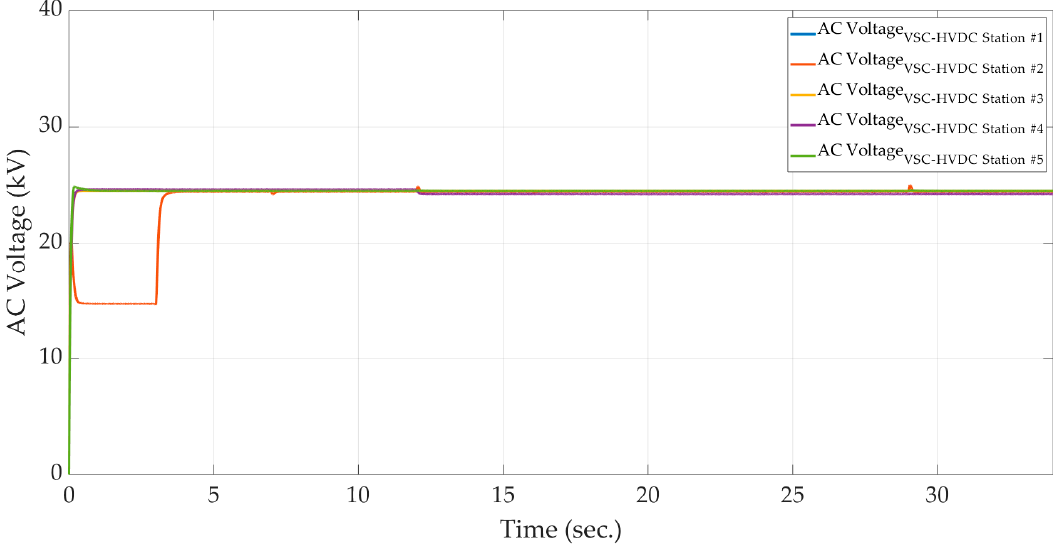
Figure 18. The AC voltage profile of di ff erent VSC-HVDC stations in the third